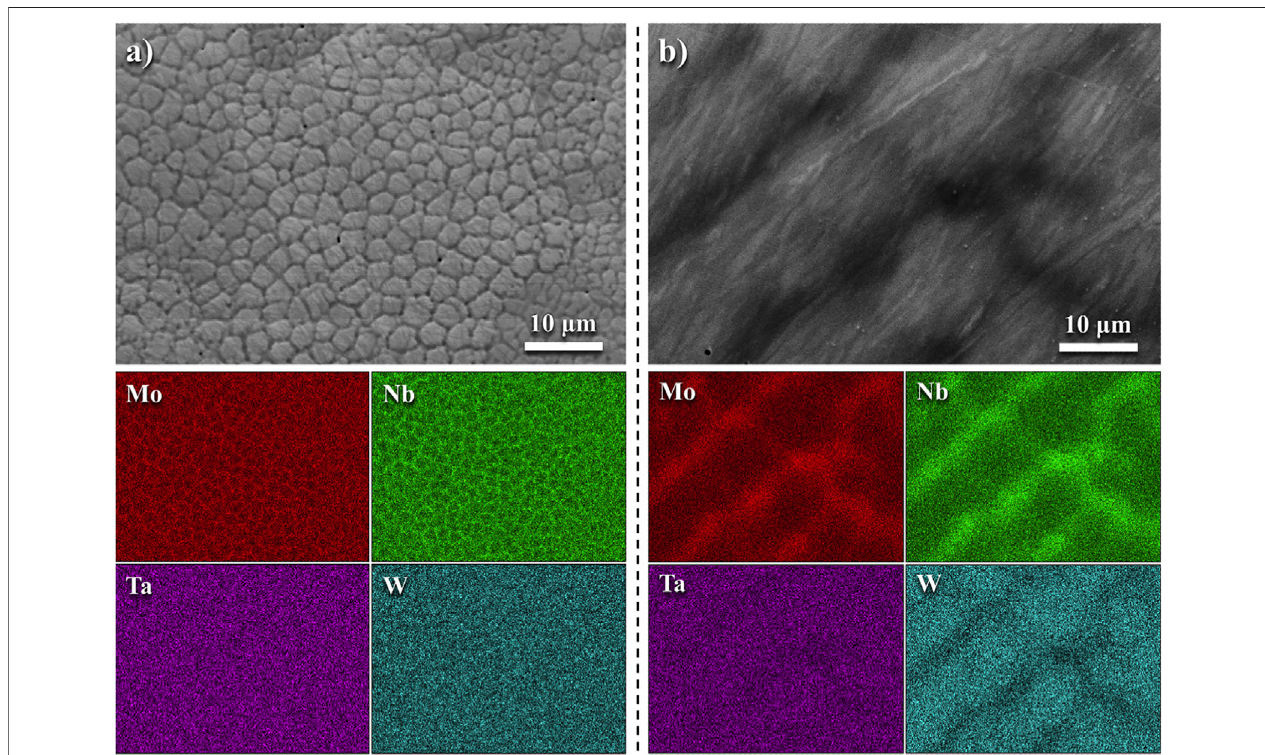
FIGURE 10 | A comparison of grain sizes and distributions in samples processed via additive manufacturing and arc-melting, (A) AMed sample reveals the formation of small grains due to the undercooling effects, (B) relatively larger grains in arc-melted samples. Both the processes reveal a near homogenous composition distribution with W and Ta within the grains, while the Mo and Nb segregated at the boundaries (adopted from (Moorehead et al., 2020)).